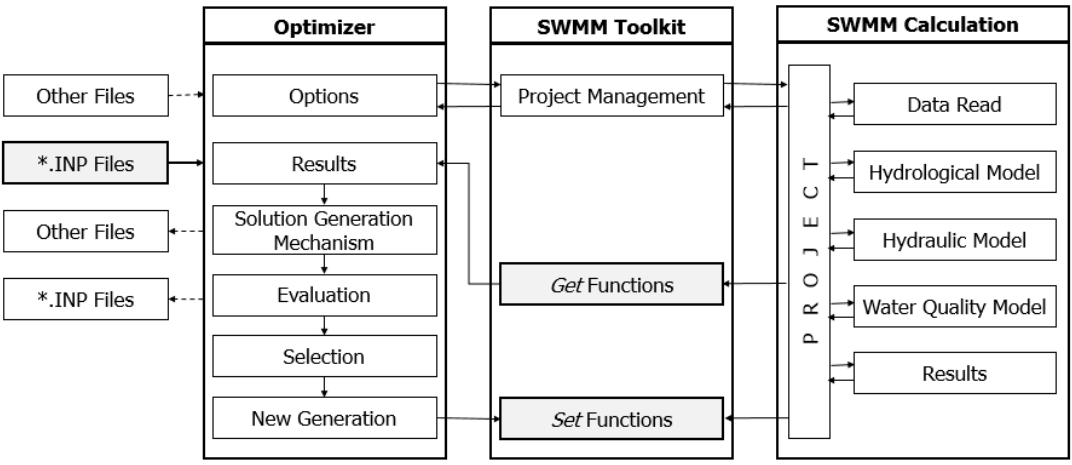
Figure 4. Interface scheme between an optimizer and SWMM toolkit [44]. In the figure, *.INP should be replaces by the name of the input file.